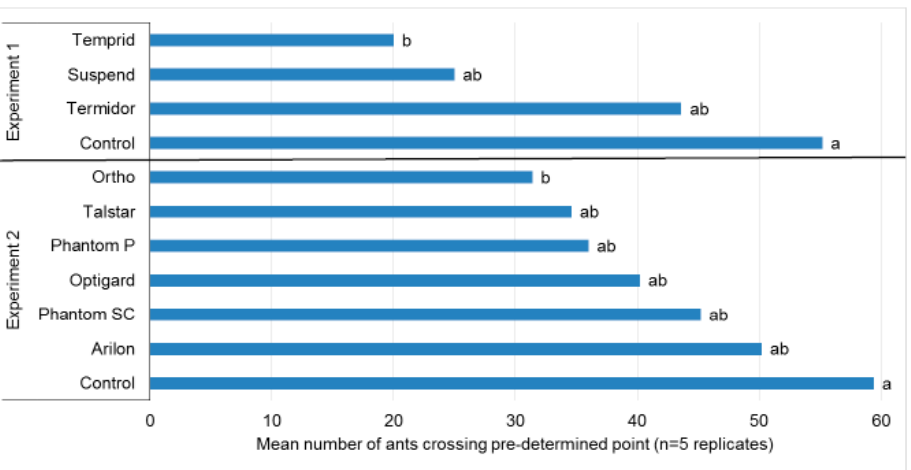
Figure 4. Mean number of Nylanderia fulva crossing a predetermined point on a painted wood panel treated with insecticide or water (control) (n = 5 replicates). Counts were taken for 1 min every 30 min for 2 h. Means in the same experiment followed by the same letter are not significantly different (Tukey’s HSD test, α = 0.05) (Experiment 1: F = 3.55, df = 3, 16, P = 0.0385, Experiment 2: F = 2.69, df = 6, 28, P = 0.0342).